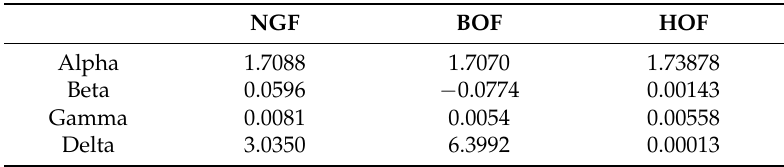
Table 3. Alpha-Stable Distribution Parameters.